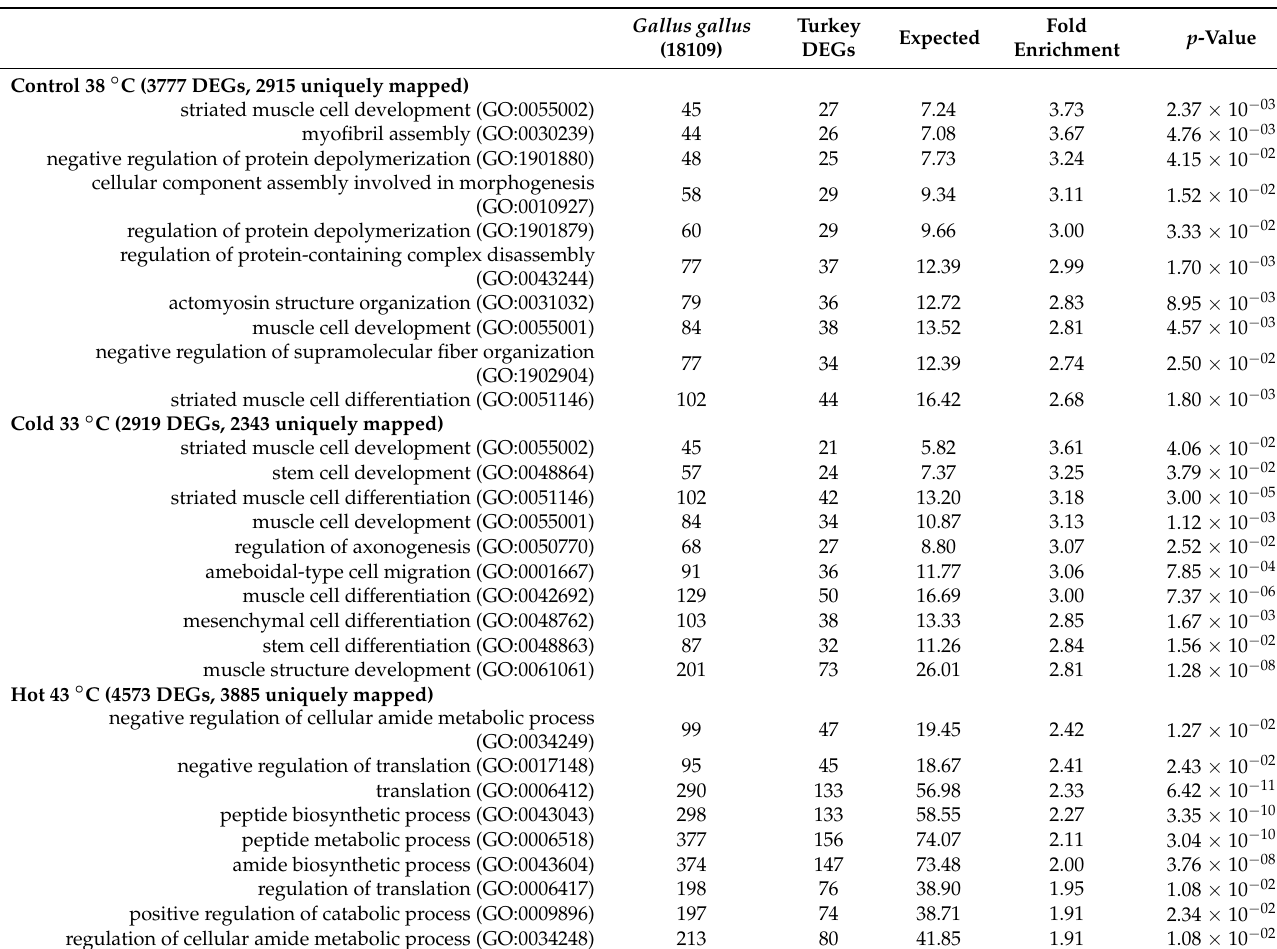
Table 4. PANTHER Overrepresentation test of DEGs in the NCT cells relative to the RBC2 after 48 h of differentiation. Shown are the gene ontology categories with the greatest fold enrichment in the GO biological process category 1